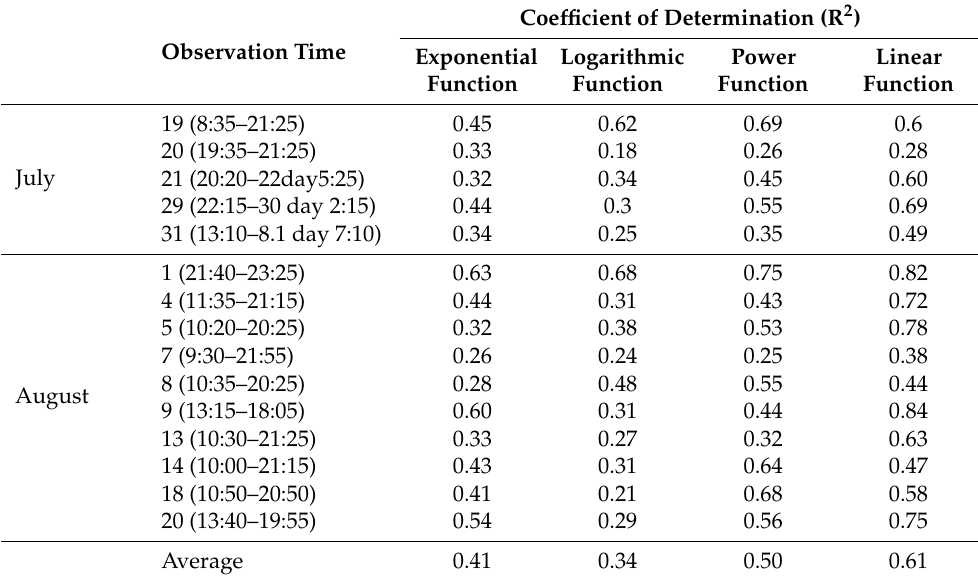
Table 1. Fitting analysis of saltation particle numbers and sand collection quantity.